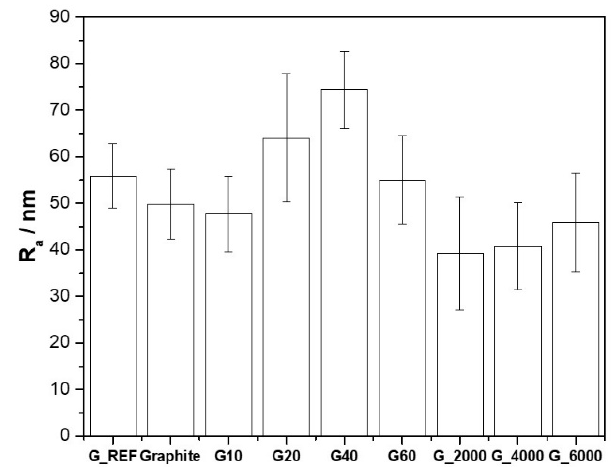
Figure 3. Surface roughness (R a ) for the different carbon materials.